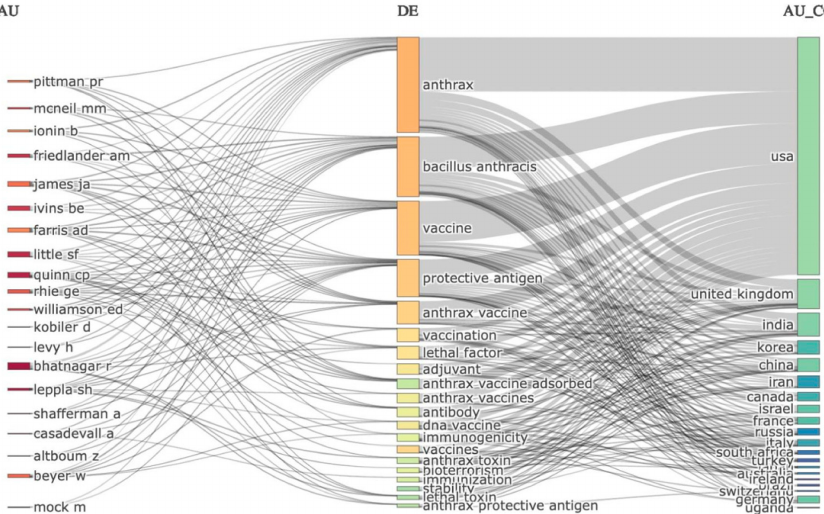
Figure 9. Relations between authors ( left ), keywords ( middle ), and countries ( right ) in anthrax vaccine